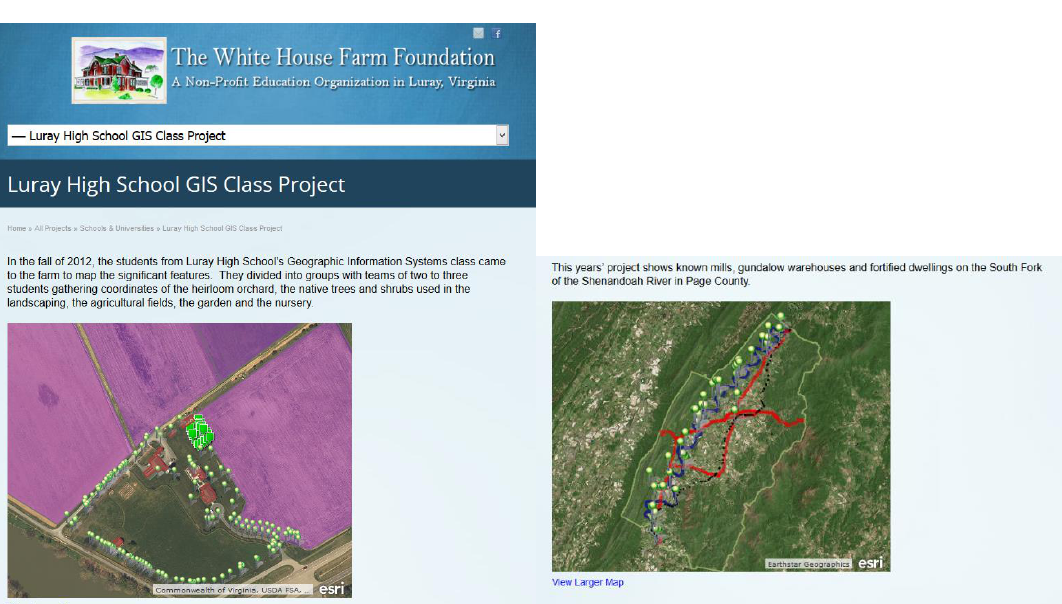
Figure 2. Student Project with Advanced GPS Unit (https://whfarmfoundation.org/all-projects/schools-universities/luray-high-school-gis-class-project/).